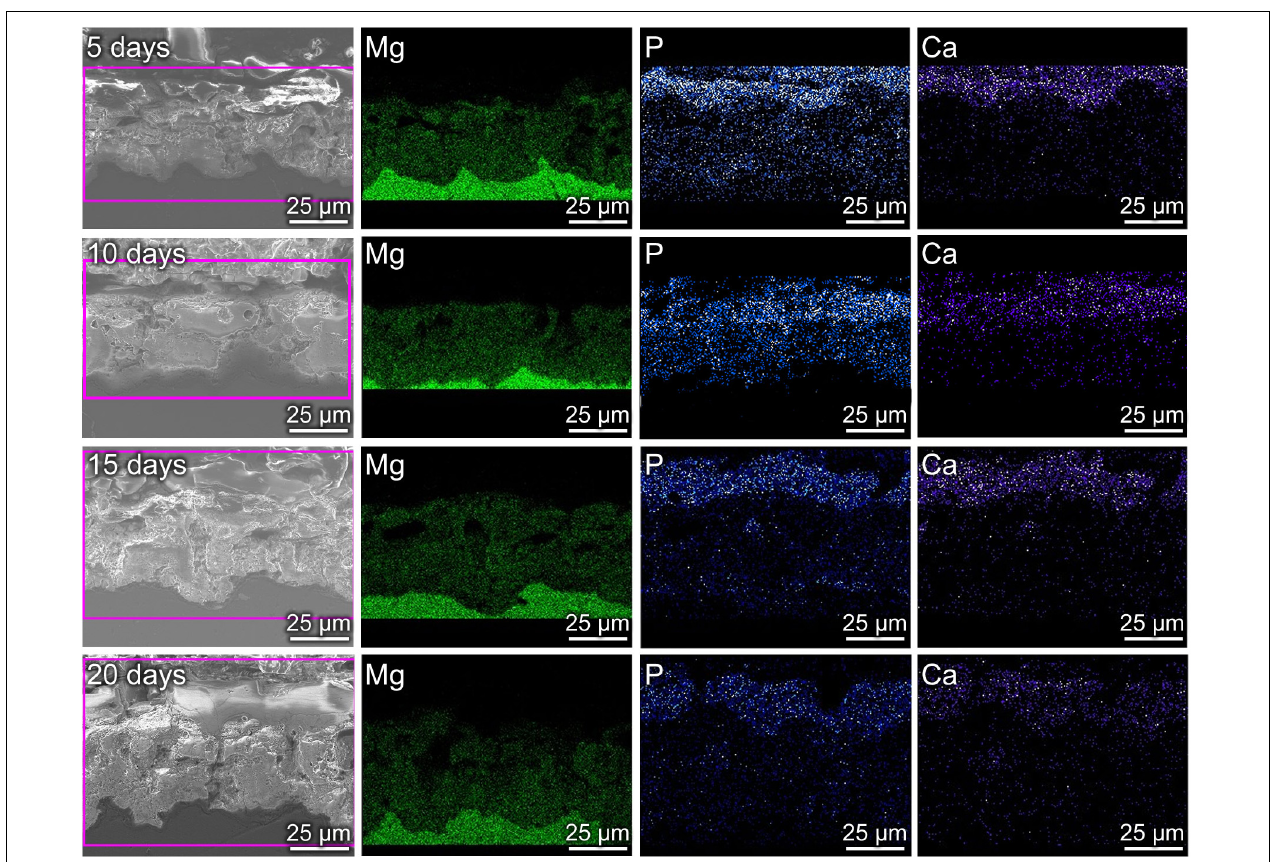
FIGURE 7 | Element distribution on the cross section of MAO-ED coatings.